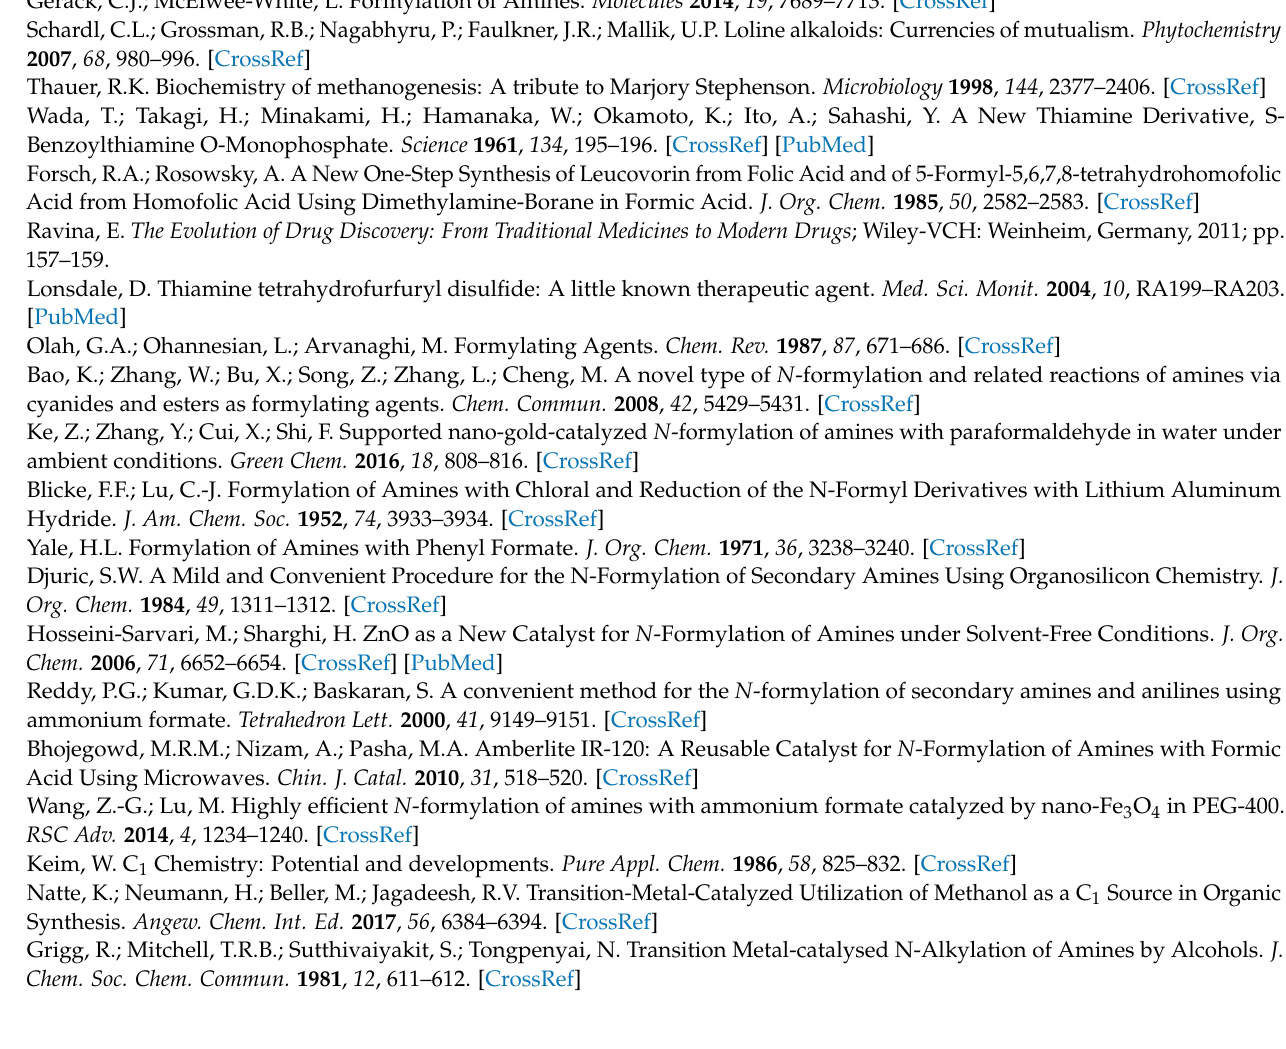
loading, Figure S1. SEM analysis, Figure S2. SEM-EDS analysis, Figure S3. EDS map spectrum, Figure S4. HR-TEM analysis, Figure S5. BF-STEM and HADDF-STEM analysis, Figure S6. Particle distribution of AuPd–NPs, Figure S7. XPS analysis, Figure S8. ICP-AES analysis, Figure S9. XRD analysis, Figure S10. SEM, EDS, and ICP-AES analysis of Au x Pd y –Fe 3 O 4 , Figure S11. SEM analysis of recycled catalyst, Figure S12. HR-TEM analysis of recycled catalyst, Figure S13. SEM analysis of AuPd–NPs, Figure S14. Kinetic data of N -formylation, Table S6. Substrate scope under high substrate concentration, Figure S15. Determination of the methanol oxidation products, Figure S16. Initial kinetics of HCHO-DNPH generation, Table S7. Control